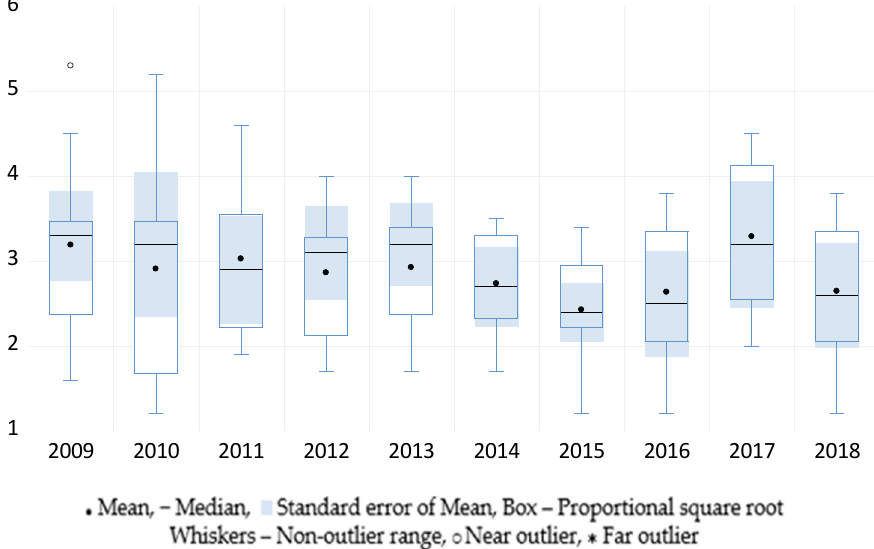
Figure 3. Boxplot of NIM in CEE countries, 1995–2018 (%).